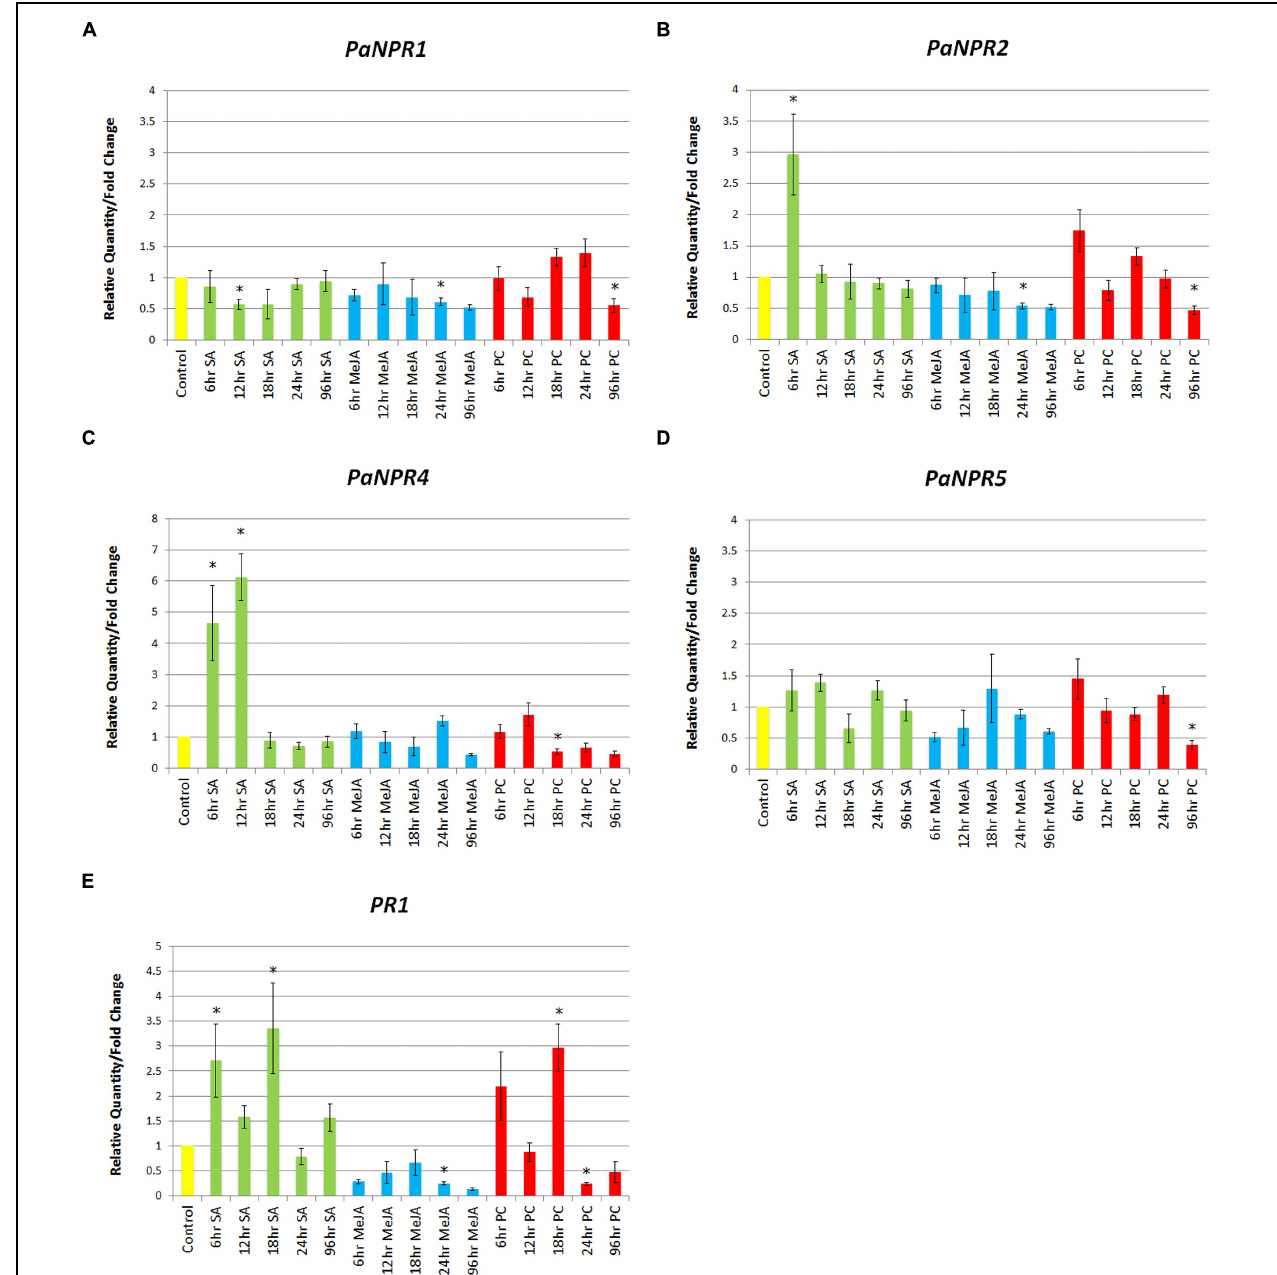
FIGURE 3 | Expression of PaNPR1 -like genes as well as PaPR1 in response to SA, JA, and Phytophthora cinnamomi treatment. Normalized relative quantities (fold change) for (A) PaNPR1 , (B) PaNPR2 , (C) PaNPR4 , (D) PaNPR5 , and (E) PaPR1 were calculated using the method described by Pfaffl (2001). The response is indicated by vertical bars across five time points for SA